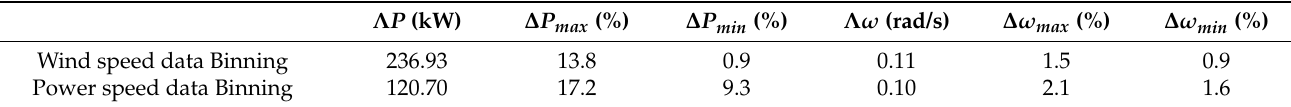
tend to be consistent, and the rated speeds are nearly the same. The maximum